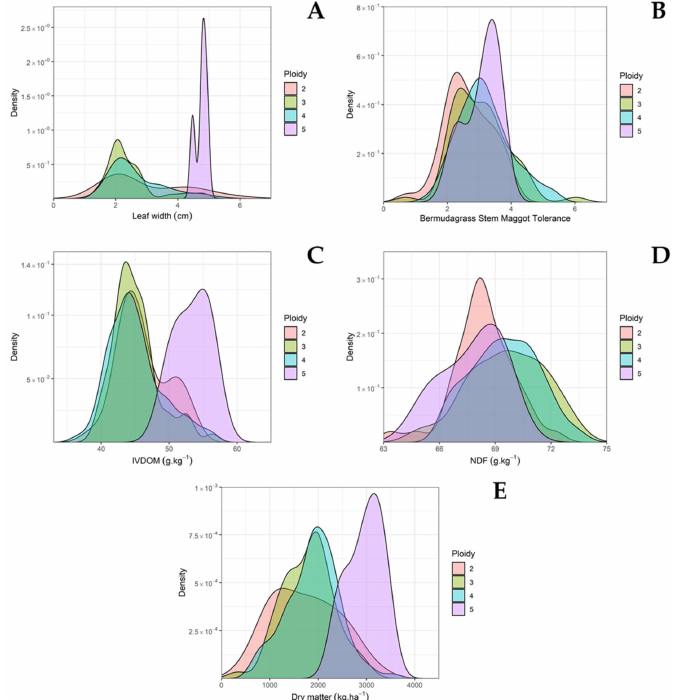
Figure 4. Density plots showing the phenotypic trait variation by ploidy level for ( A ) leaf width (cm), ( B ) Bermudagrass Stem Maggot tolerance, ( C ) in vitro digestible organic matter (IVDOM), ( D ) neutral detergent fiber (NDF), and ( E ) dry matter yield. Traits were measured in accessions of bermudagrass from the USDA